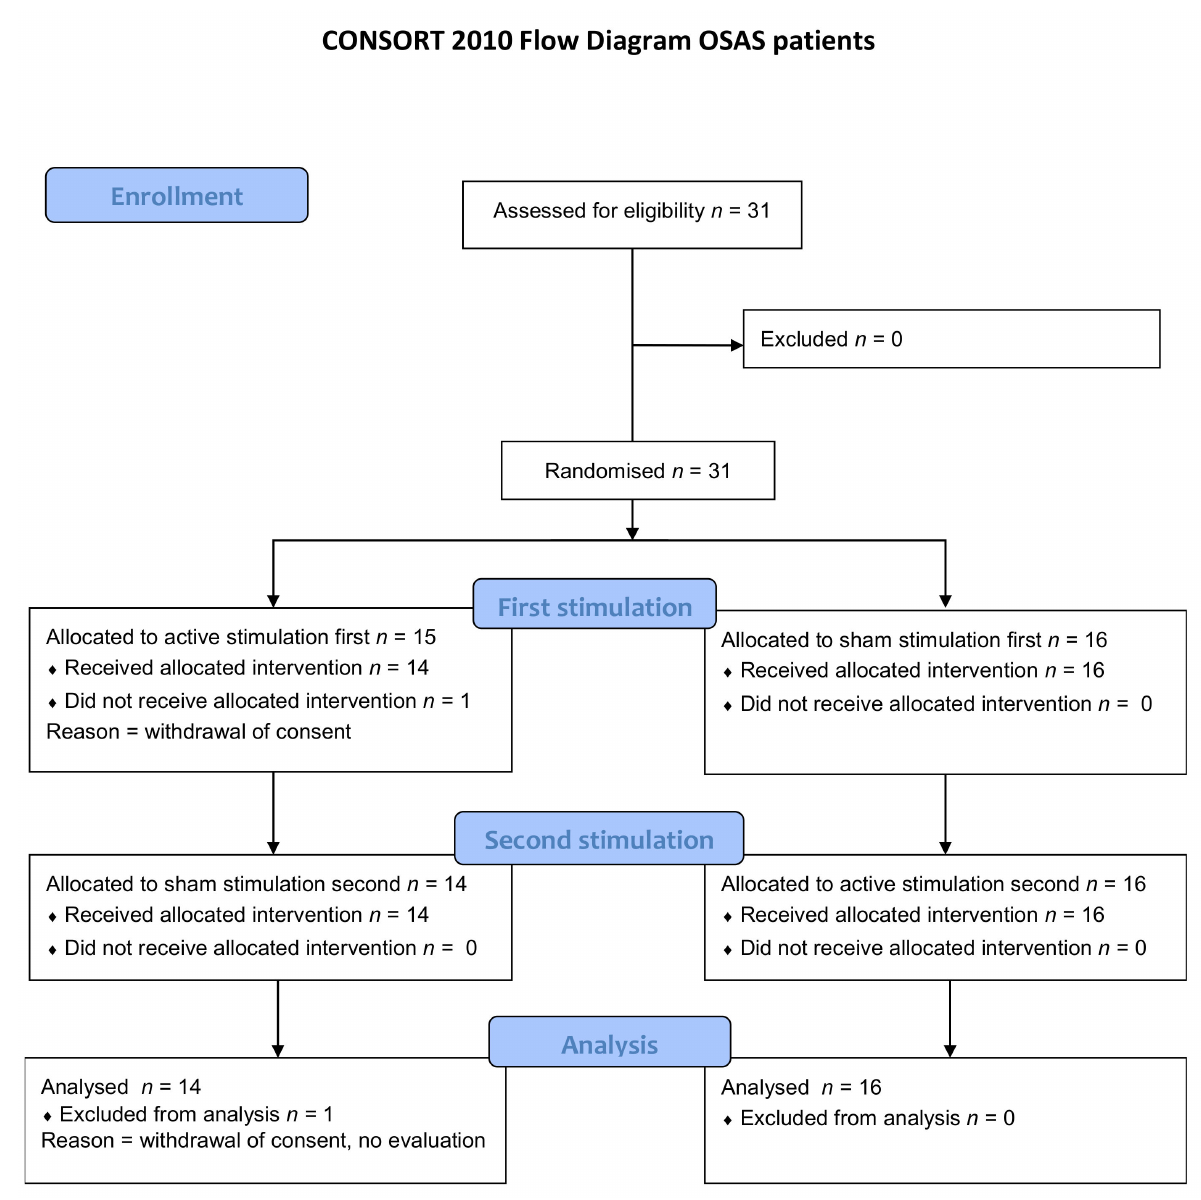
Figure 3. Consort Flow diagram for OSAS